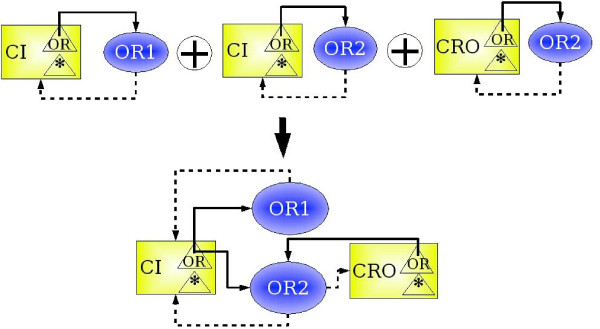
Union and compression of interaction networks. Three networks sharing species and regulatory sites can be combined into one by a composition and compressed by collapsing equivalent species and sites. All existing interactions are preserved.